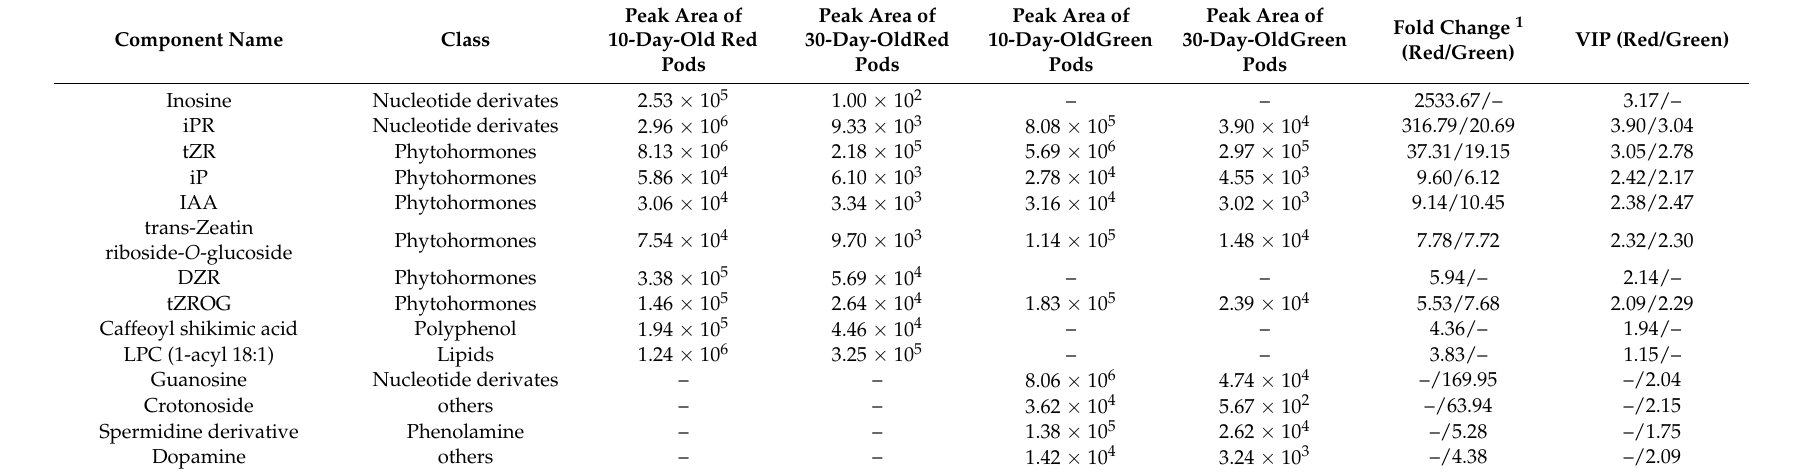
Table 3. Distinct metabolites of red and green pods at different growth